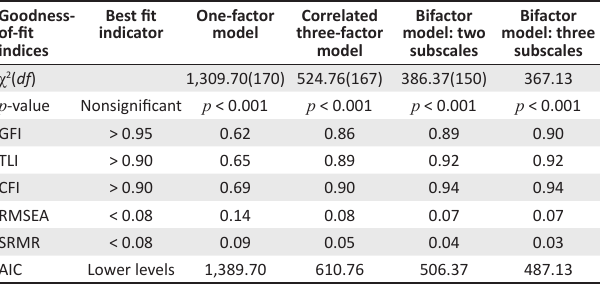
FIGURE 4 : Bifactor model of UCLA-LS3: Three subscales. TABLE 3: Fit indices for three models of the structure of UCLA-LS3. TABLE 4: Dimensionality indices for